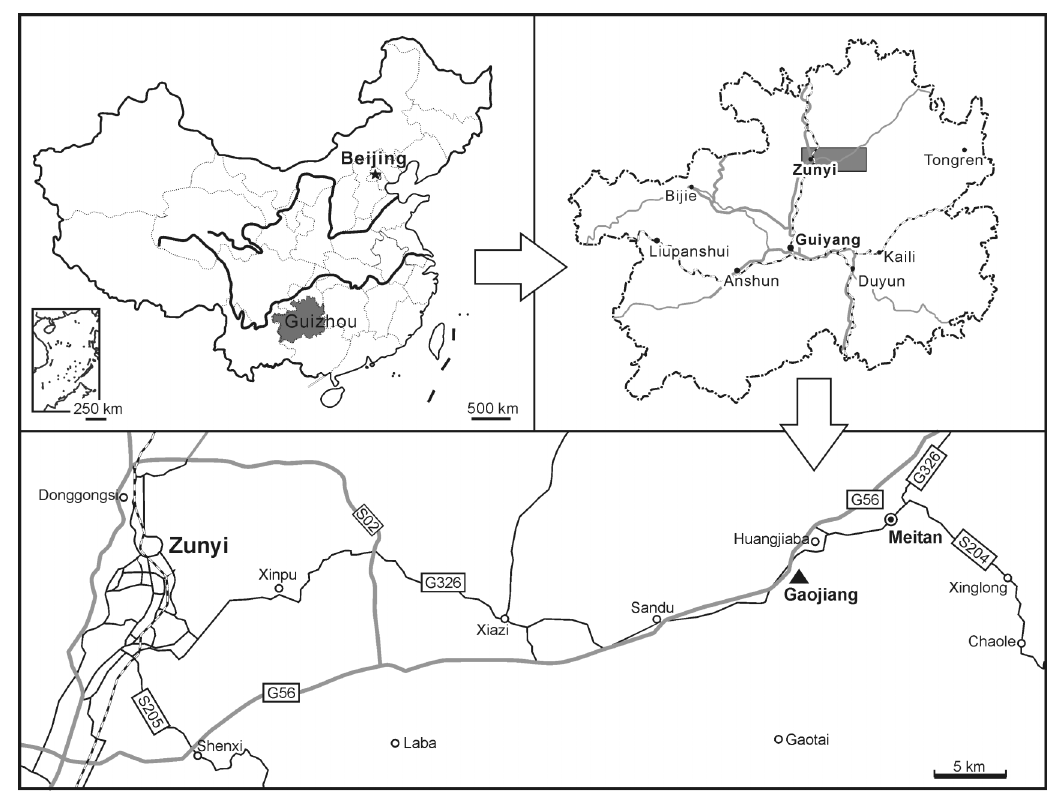
Fig. 1. Locality map of Halysites gaojiangensis sp. nov. described in this